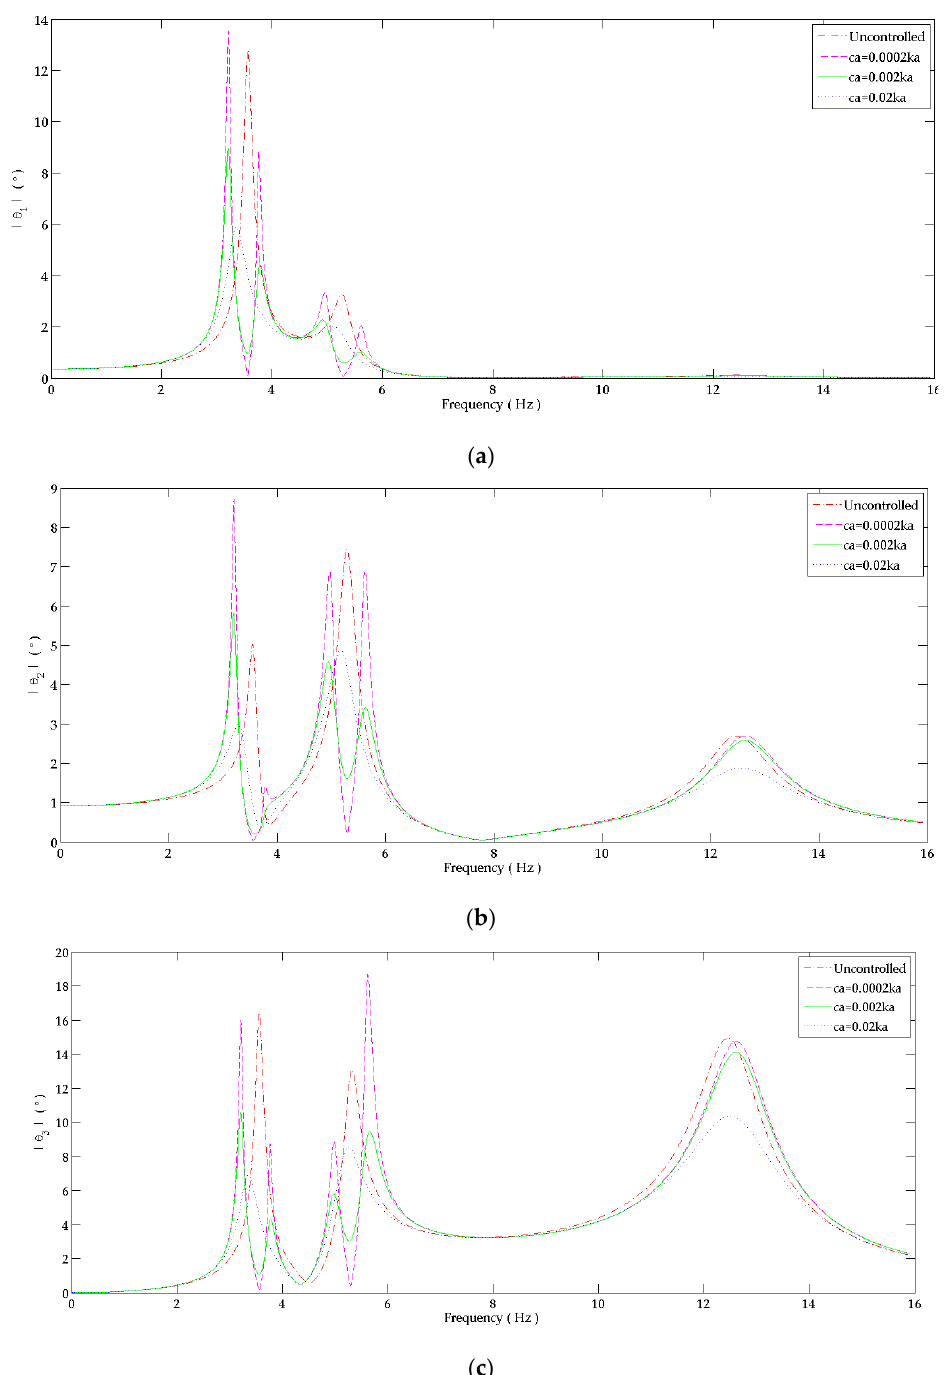
Figure 7. Response in the frequency domain at: ( a ) Shoulder joint; ( b ) Elbow joint; ( c ) Wrist joint. The behavior at each joint is studied when attaching to the forearm due to the ”dual DVA” tuned at wrist joint’s responses. It is compared to the response of the uncontrolled